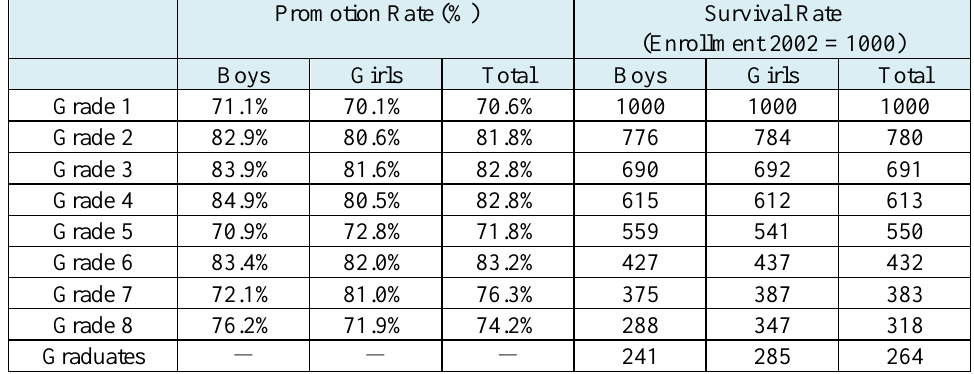
Table 4-6: Primary Promotion Rate (2009/10) and Survival Rate to Grade 8 (2010/11) by Grade and Gender Promotion Rate (%) Survival